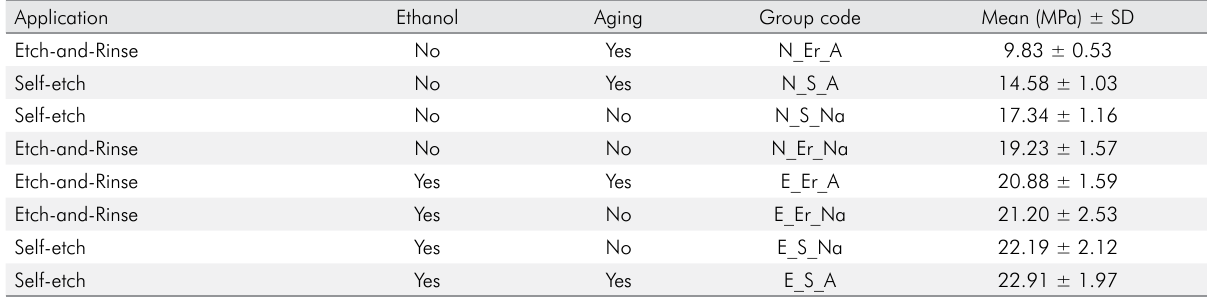
Table. Microtensile strength mean and standard deviation obtained in the different groups.